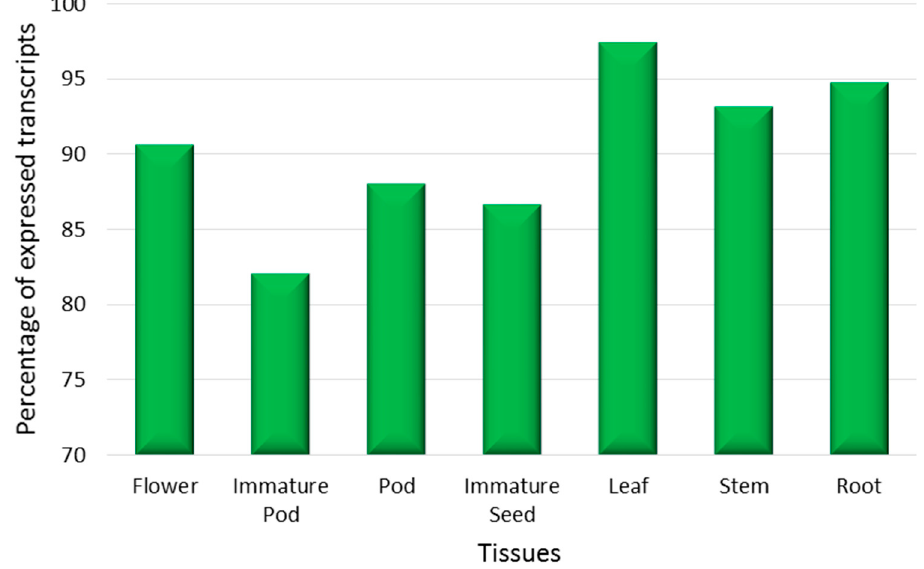
Figure 3. Expression patterns in different tissue samples: The percentage of transcripts expressed in each tissue sample.